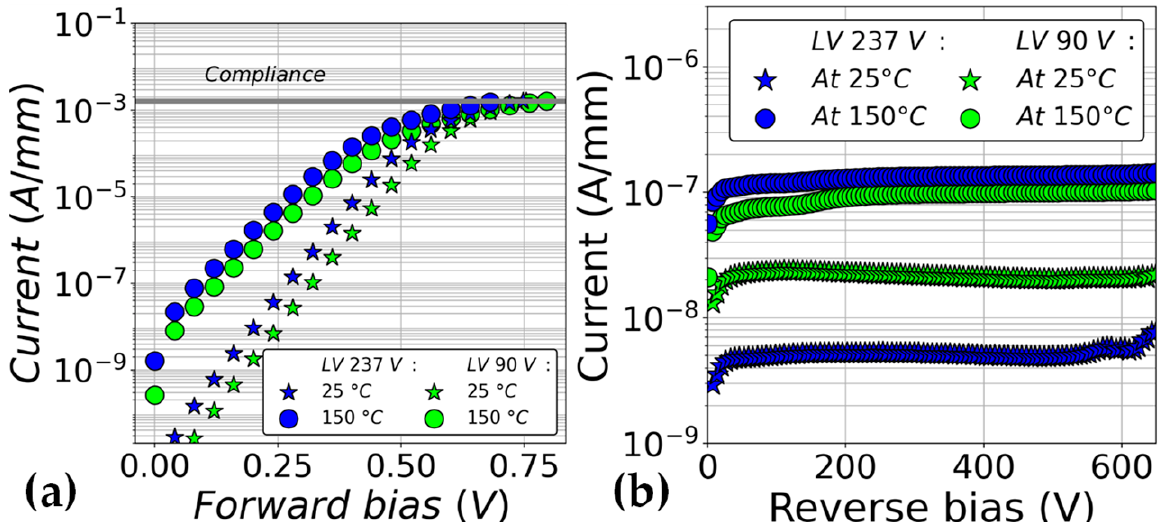
Figure 2. ( a ) Typical low voltage forward characteristics; ( b ) Typical reverse characteristics of the two experimental splits.